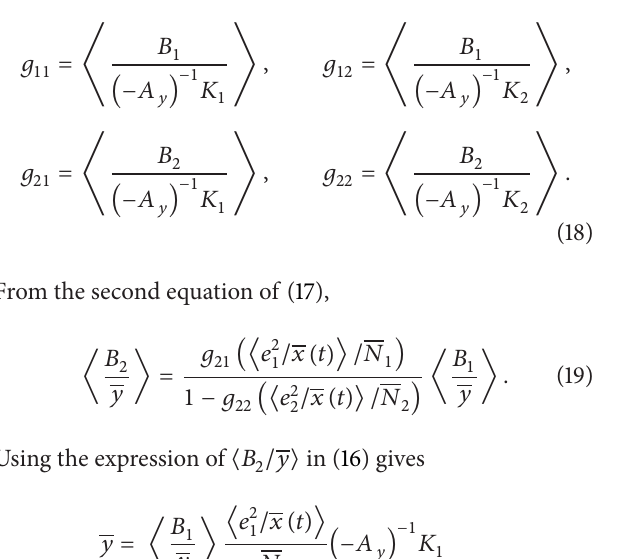
Figure 2: Trajectories of susceptible individuals of (1) for different initial conditions when 𝛽 1 = 0.002 and 𝛽 2 = 0.003 (such that 𝑅 1 0 = = 0.4980 ). We can observe the global stability of DFE 0.3691 and 𝑅 2 0 when 𝑅 0 < 1 . All other parameters are as in Table